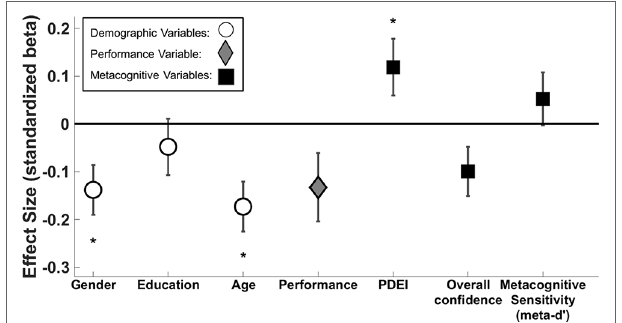
FIGURE 2 | Standardized beta coefficients ( ± standard error) of predictors of depression score. White circle markers indicate demographic variables, the gray diamond indicates perceptual performance (d’ across both tasks), and black squares indicate metacognitive variables. We demonstrate significant effects of gender ( β = -0.138, p = 0.008), age ( β = -0.173, p = 0.001), and PDEI ( β = 0.119, p = 0.045). Performance (d’ across both tasks) and overall confidence narrowly missed significance ( β = -0.132, p = 0.063; β = -0.099, p = 0.056, respectively). *p <